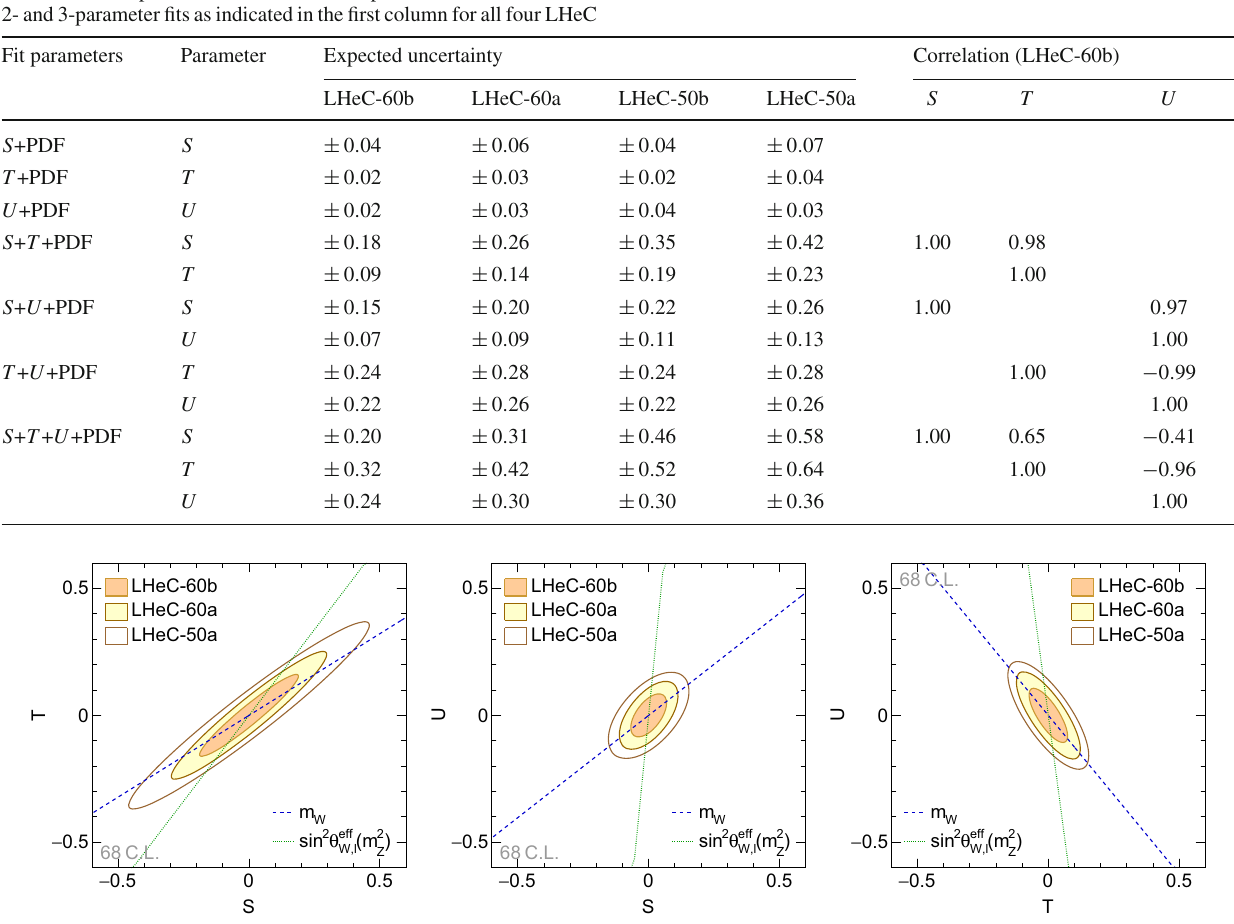
scenarios. In the case of 2- and 3-parameter fits, the last columns show the correlation matrices